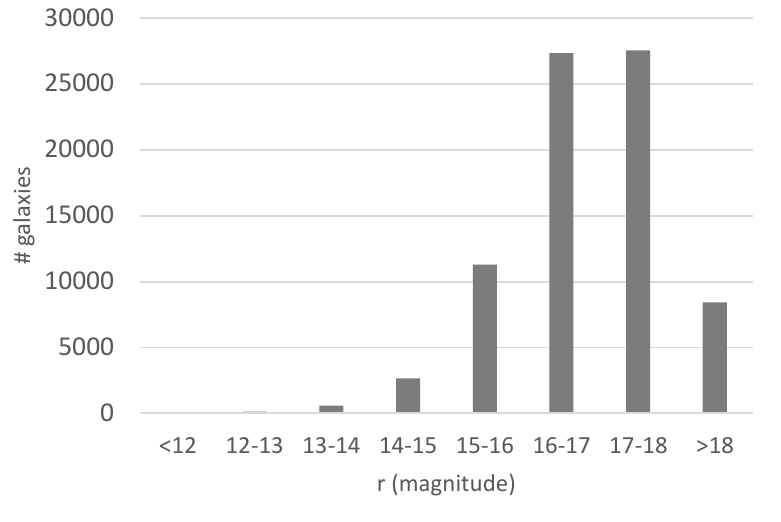
Figure 1. The distribution of the exponential r magnitude of the galaxies in the